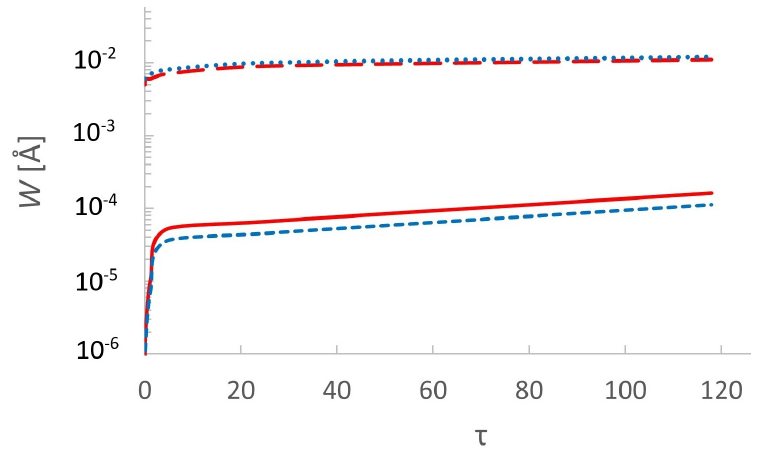
Figure 2. Dependence of Stark and Doppler full widths at half intensity maximum of Zn III 4p 1 P o – 4d 1 S, λ = 1203.3 Å (red, Stark—solid line, Doppler—long dashes) and 4p 3 P o –4d 3 S, λ = 1326.9 Å (blue, Stark—dashes, Doppler—dots) spectral lines, on the Rosseland optical depth in the atmosphere of an A type star. Model of stellar atmosphere [38] is with parameters T ef f = 8500 K and log g = 4.5.